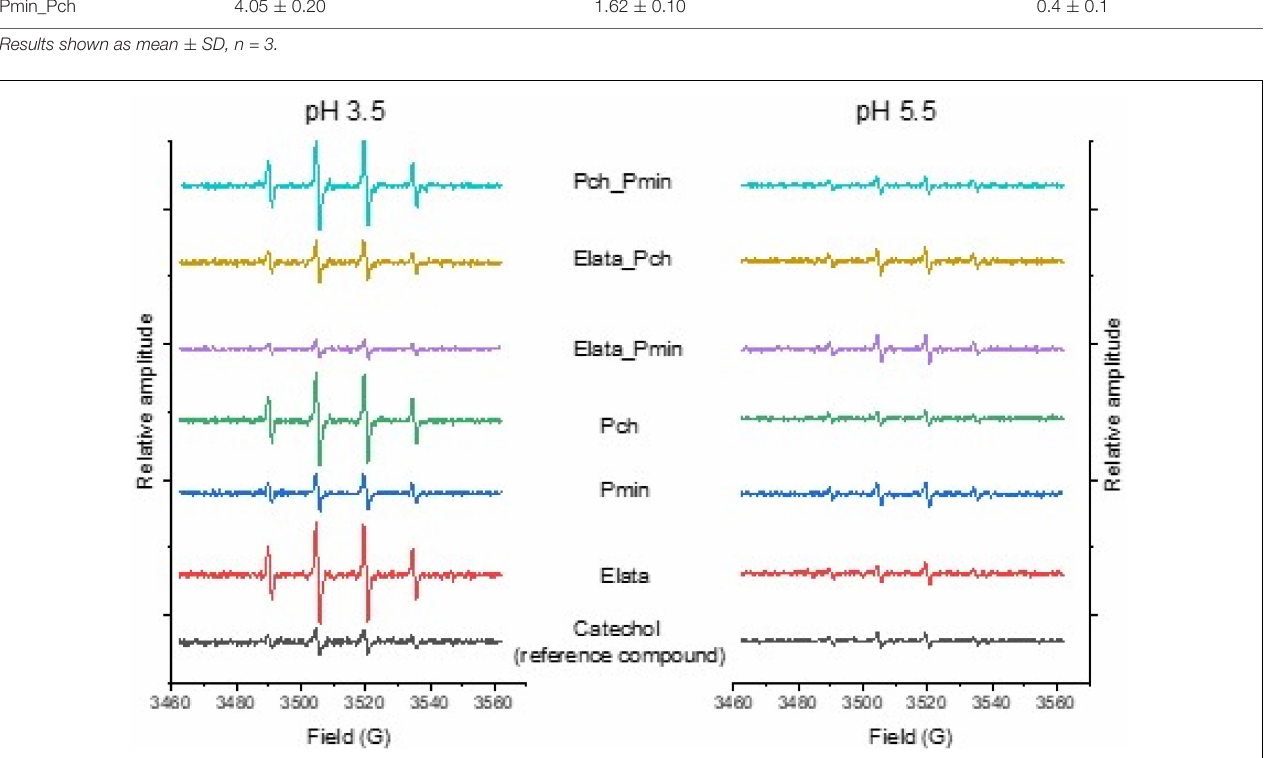
FIGURE 3 | Electron paramagnetic resonance (EPR) spectra of GTD fungal extracts spiked with DMPO to detect hydroxyl radicals. The relative amplitude of each 4-peak spectra reflects the amount of hydroxyl radical produced relative to a catechol standard. Fungi were grown alone, and in consortia, to produce the extracts analyzed in this work. TABLE 2 | Metabolites produced by E. lata , P. minimum , and P. chlamydospora with previously reported capacity for iron reduction.